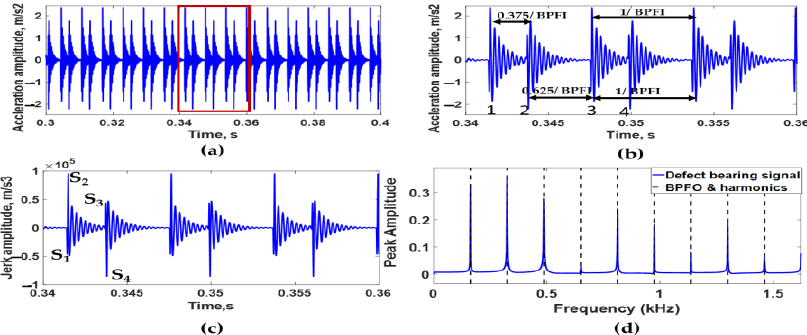
Figure 8. ( a ) Simulated acceleration signal of bearing with double defects (bump and dent) on its inner race at 15° ( b ) enlarged simulated acceleration signal between 0.34 s and 0.36 s, ( c ) simulated jerk signal, and ( d ) envelope spectrum of simulated acceleration signal .